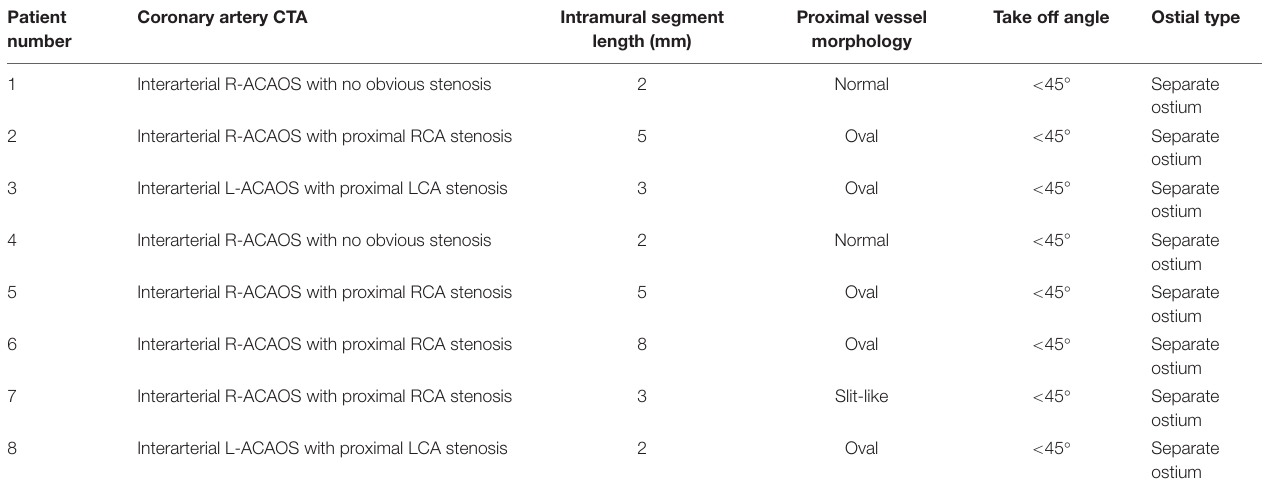
TABLE 3 | Coronary artery computed tomography angiography